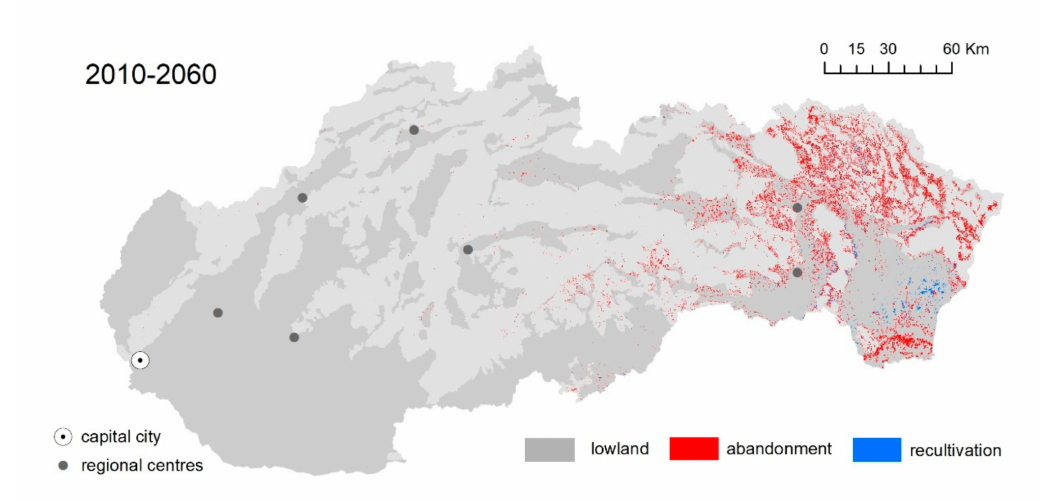
Figure 7. Future scenario of agricultural land use change in